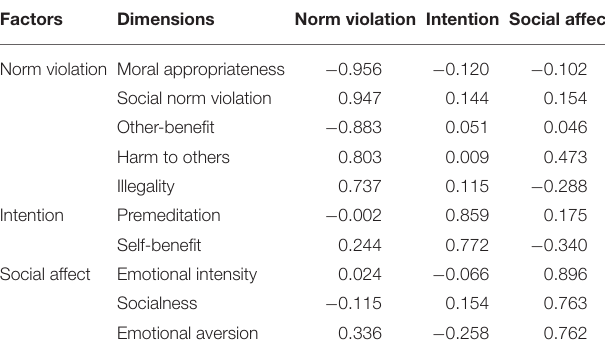
TABLE 1 | Pattern matrix for the three factors that were extracted through EFA method in Iran.